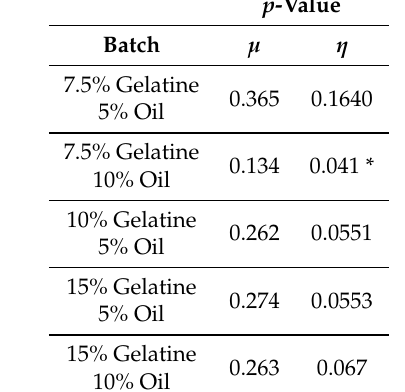
Figure 12. Pearson’s correlation between shear stiffness measured with TWE and shear stiffness obtained with SWE. Pearson correlation coefficient r = 0.9942. Table 10. Shear elasticity and shear viscosity measurements comparison between TWE and SWE for each batch of gelatine. p -Value obtained from the Student’s T-test was the metric used for this comparison. (* p -value < 0.05). p -Value